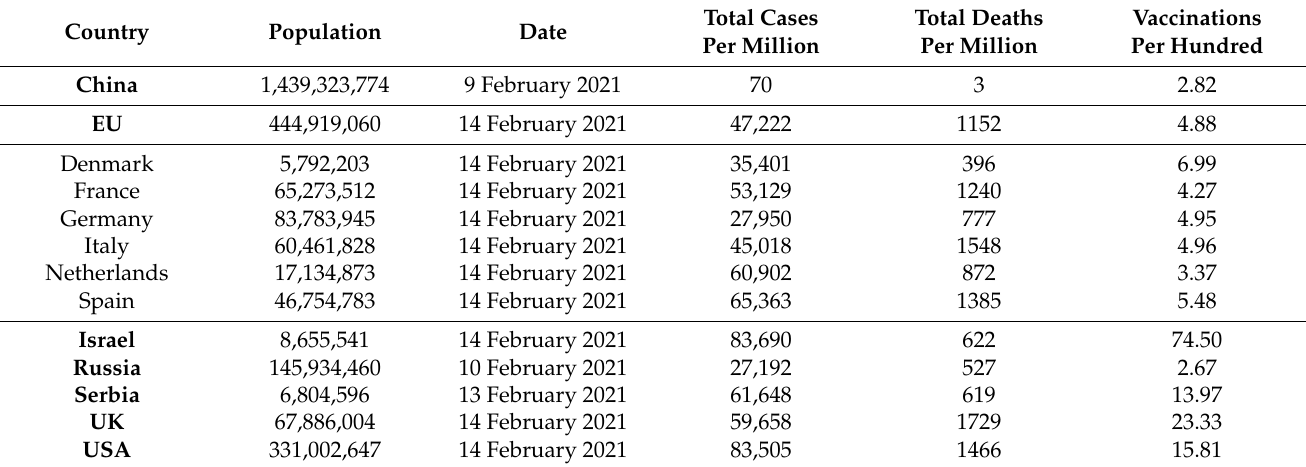
Table 1. Vaccinations per 14 February 2021 (Source [3]).